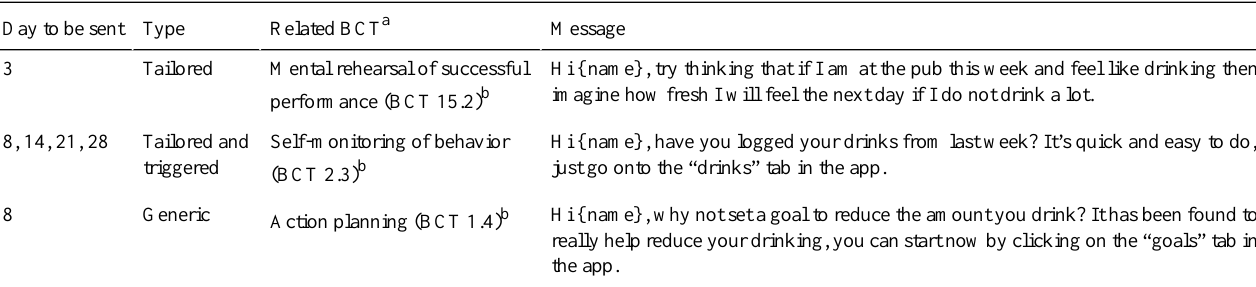
Table 1. An example of the type of personalized SMS text messages sent to an individual throughout their use of the app. MessageRelated BCT a TypeDay to be